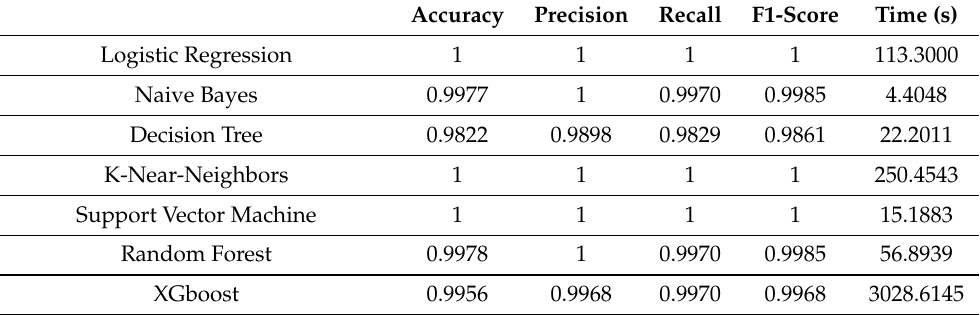
Table 8. Result of 50% attack data.